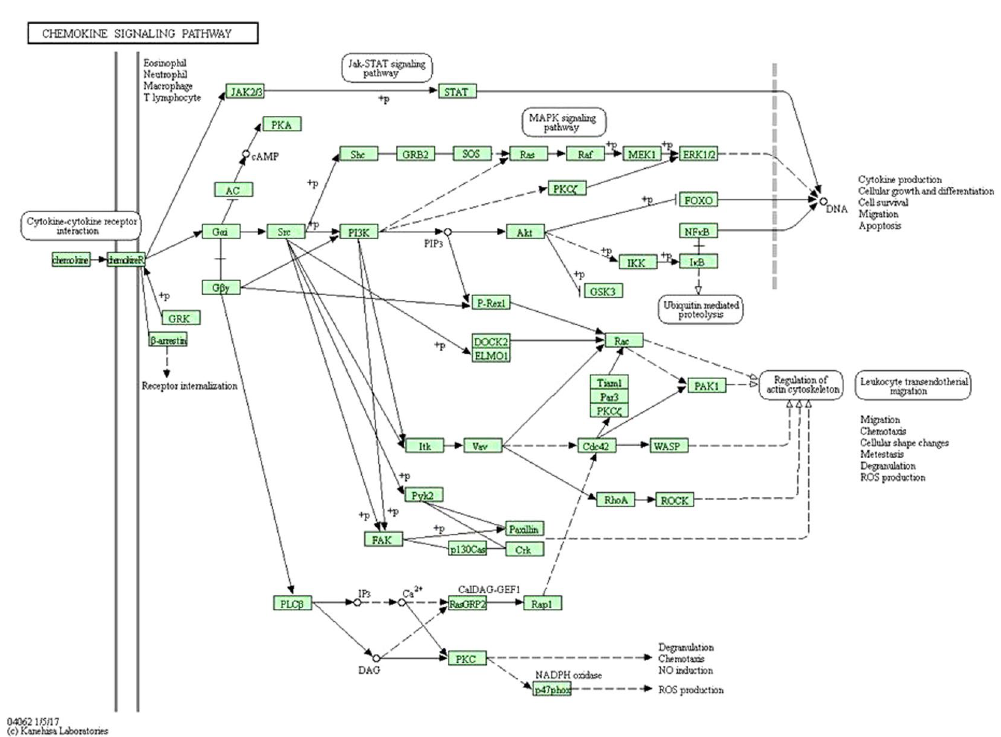
Figure 1. Chemokine signalling pathway